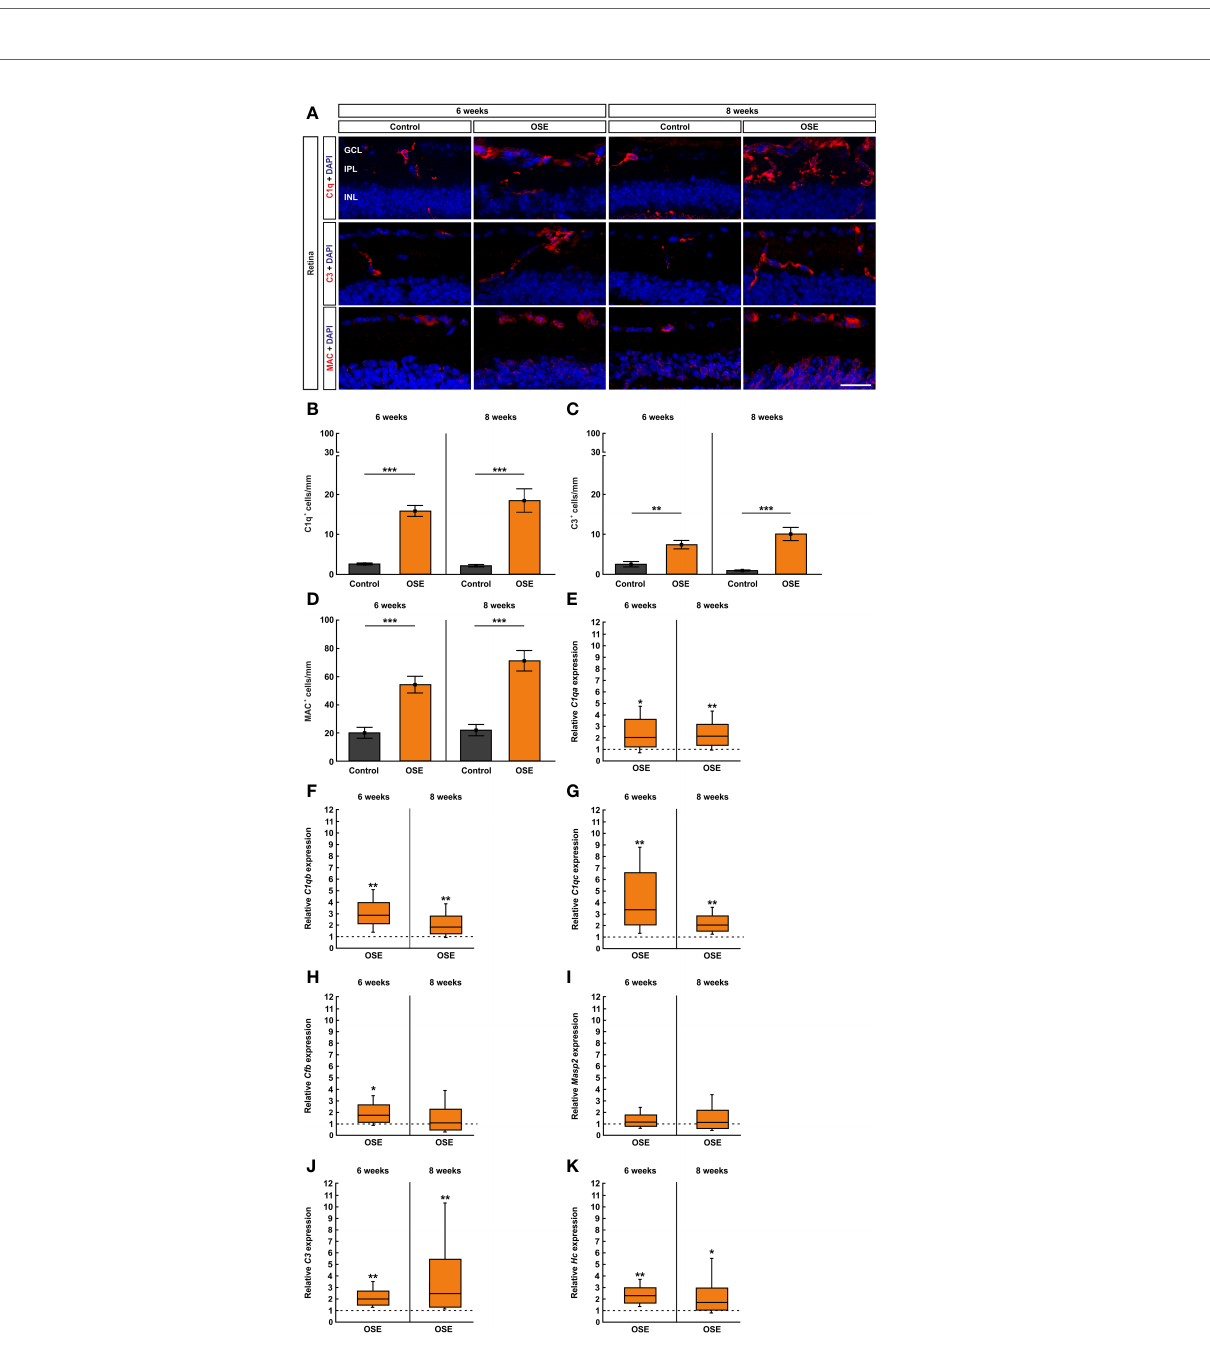
FIGURE 7 | Activation of the classical pathway of the complement system in the retina of OSE mice. (A) Staining of retinal cross-sections with the complement markers C1q (red), C3 (red), and MAC (red), while DAPI counterstained cell nuclei (blue). (B) A signi fi cantly increased number of C1q + cells was found in the OSE group in the GCL, IPL, and INL after six weeks. An increase of C1q + cells of 16.5% was noted at the eight weeks´ time point. (C) The total number of C3 + cells in GCL, IPL, and INL was signi fi cantly elevated in six-week-old OSE mice. After eight weeks, C3 + cells were even further increased. (D) The quanti fi cation of MAC + cells revealed a signi fi cant increase among the OSE group at six weeks. A progression of increasing MAC + cells in OSE mice was observed after eight weeks. (E – G) . Complement pathway factor C1qa , C1qb , and C1qc (classical pathway) mRNA expression were signi fi cantly upregulated in six- and eight-week-old OSE mice. (H) At six weeks of age, a signi fi cant increase of Cfb (Factor B, alternative pathway) mRNA expression was noted in OSE retinae, whereas the expression was not signi fi cantly altered later on, at eight weeks. (I) No signi fi cant differences were found in Masp2 mRNA (lectin pathway) at six and eight weeks. (J) An increased C3 (common pathway) mRNA expression was detected in the OSE group at both ages. (K) Likewise, the mRNA level of Hc (C5, common pathway) was upregulated at six as well as at eight weeks in OSE retinae. Data are shown as mean ± SEM for immunohistochemistry, relative values for RT-qPCR are median ± quartile ± maximum/minimum. The dotted lines in (E – K) represent the relative expression level of the control group. GCL, ganglion cell layer; IPL, inner plexiform layer; INL, inner nuclear layer. *p < 0.05, **p < 0.01, ***p < 0.001. Scale bar: 20 m